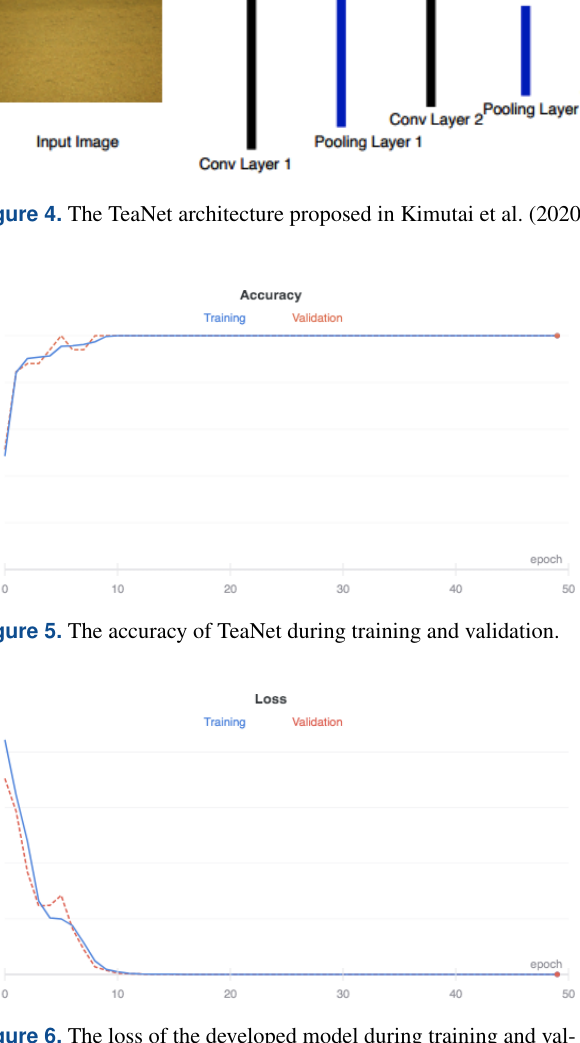
Figure 6. The loss of the developed model during training and val- idation